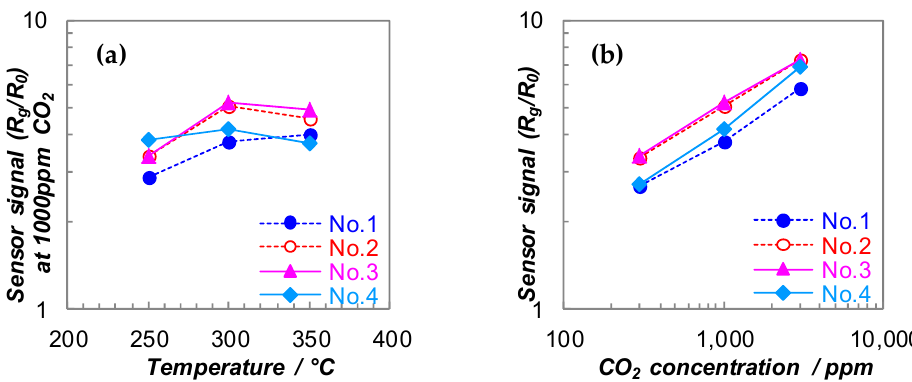
Figure 1. CO 2 Sensing properties: ( a ) Sensor signal at 1000 ppm CO 2 vs operation temperature; ( b ) Sensor signal vs CO 2 concentration.